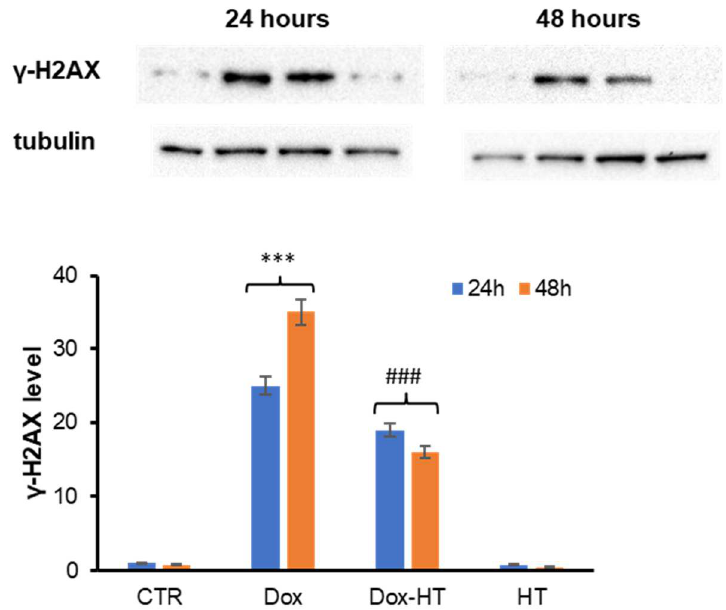
Figure 7. Role of HT in Dox-induced DNA damage. Western blot analysis of phospho-histone H2AX (γ-H2AX) in H9c2 cells exposed to 0.1 μM Dox (Dox) and co-treated with 50 μM HT (Dox-HT). CTR: untreated cells. The images are representative of Western blotting from three different cellular extracts with similar results. Other experimental details are described in the Materials and Methods section. *** p < 0.001 versus CTR, ### p < 0.001 versus Dox.